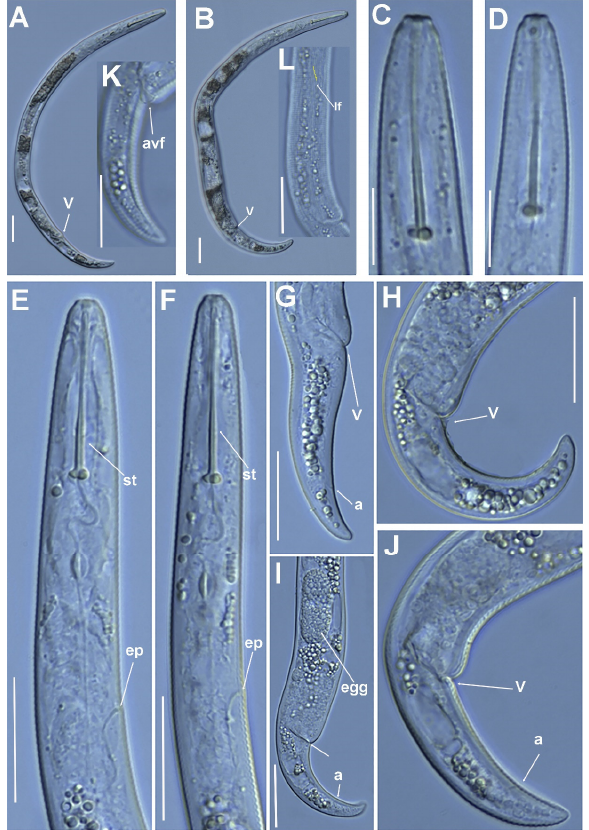
Figure 9. Micro-photomicrographs of Paratylenchus nainianus Edward & Misra, 1963 female. ( A , B ) Whole female with vulva arrowed; ( C , D ) Detail of female stylet region; ( E , F ) Pharyngeal region; ( G – K ) Female posterior region with vulva and anus (arrowed) and detail of vulva showing advulval flap (arrowed); ( L ) Detail of lateral fields (lines arrowed). Scale bars ( A , B , E – L = 20 µ m; C , D = 10 µ m). (Abbreviations: a = anus; avf = advulval flap; egg = egg, ep = excretory pore; lf = lateral field; st = stylet; V =